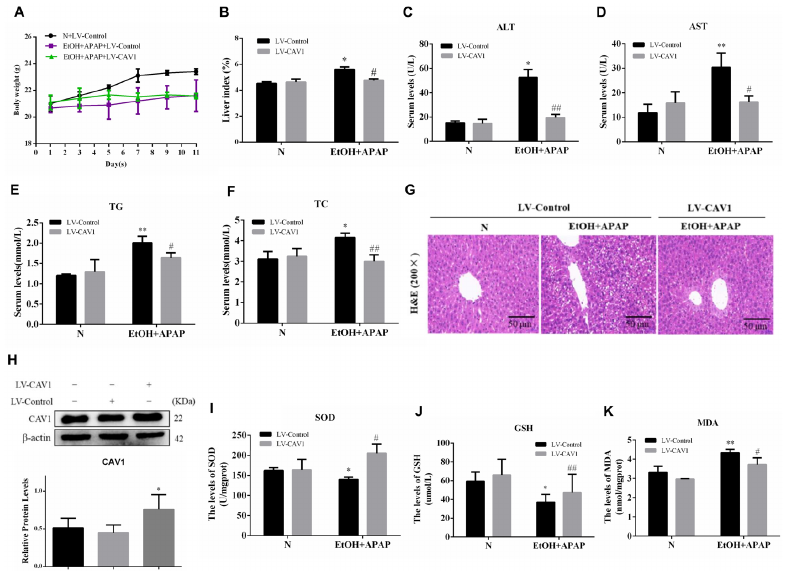
Figure 2. CAV1 reduced lipid deposition and liver injury caused by APAP in AFLD and decreased the level of oxidative stress. ( A ) The bodyweight of mice in each group. ( B ) The liver index of mice in each group. ( C ) The serum activity of ALT. ( D ) The serum activity of AST. ( E ) The serum activity of TG. ( F ) The serum activity of TC. ( G ) Representative images of hematoxylin and eosin staining results (Scale bar = 50 μm). ( H ) Western blot analysis of the relative protein levels of CAV1. ( I ) Se- rum glutathione (GSH). ( J ) Liver superoxide dismutase (SOD) activity. ( K ) Malondialdehyde (MDA) levels. Data represent the mean ± SEM ( n = 8 mice). * p < 0.05 vs. N + LV-Control group; ** p < 0.01 vs. N + LV-Control group; # p < 0.05 and ## p < 0.01 vs. EtOH + APAP + LV-Control group.